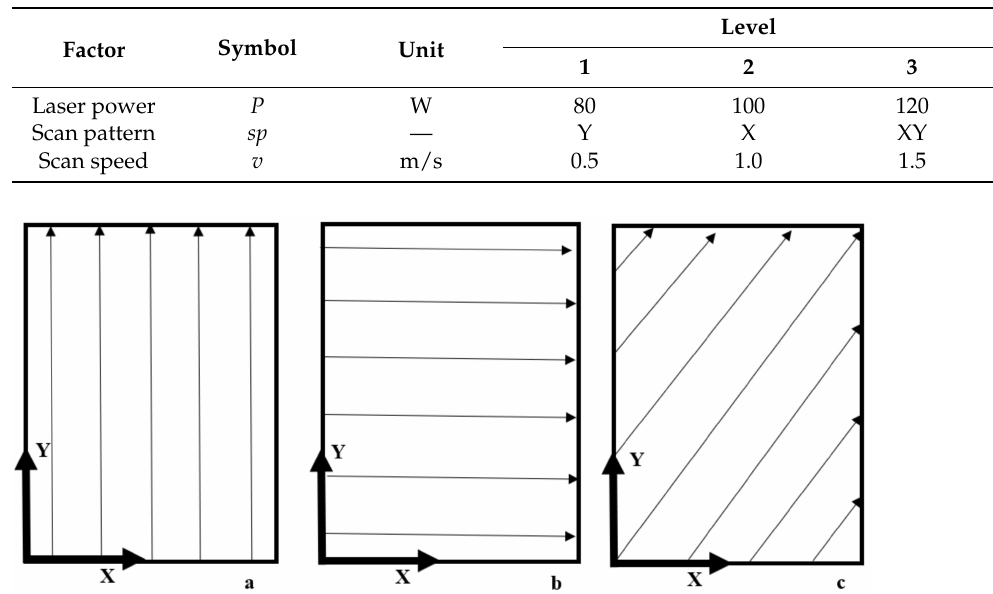
Figure 1. Flowchart of Taguchi based grey relation analysis (GRA). Table 1. Factors and their levels.